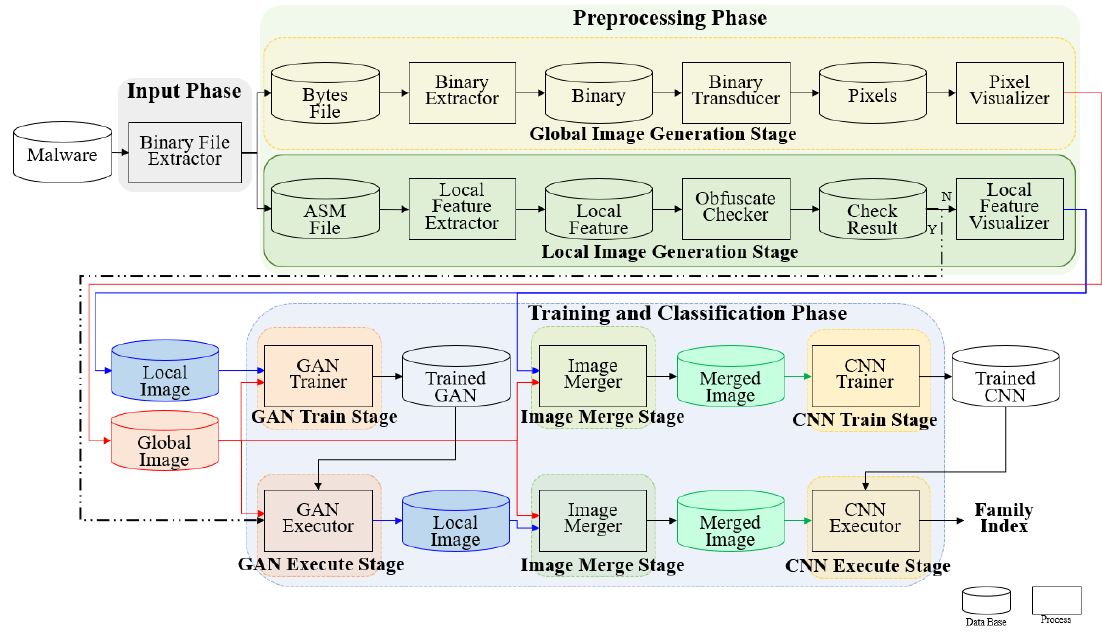
Figure 1. Overview of the proposed method.